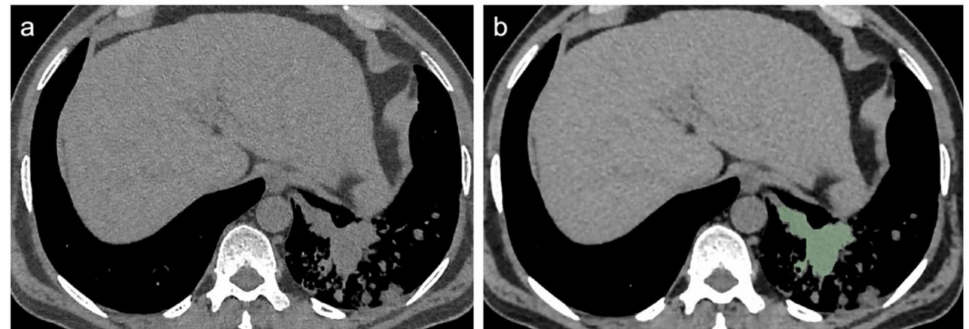
Figure 4. Mediastinal window of axial thin-section unenhanced chest CT images in a 67-year-old man with proven diagnosis of lung cancer. ( a ) Chest CT image shows, in the left inferior lobe, a consolidative opacity without air bronchogram. ( b ) The same image showing the consolidative opacity after radiomic volumetric segmentation (in green).